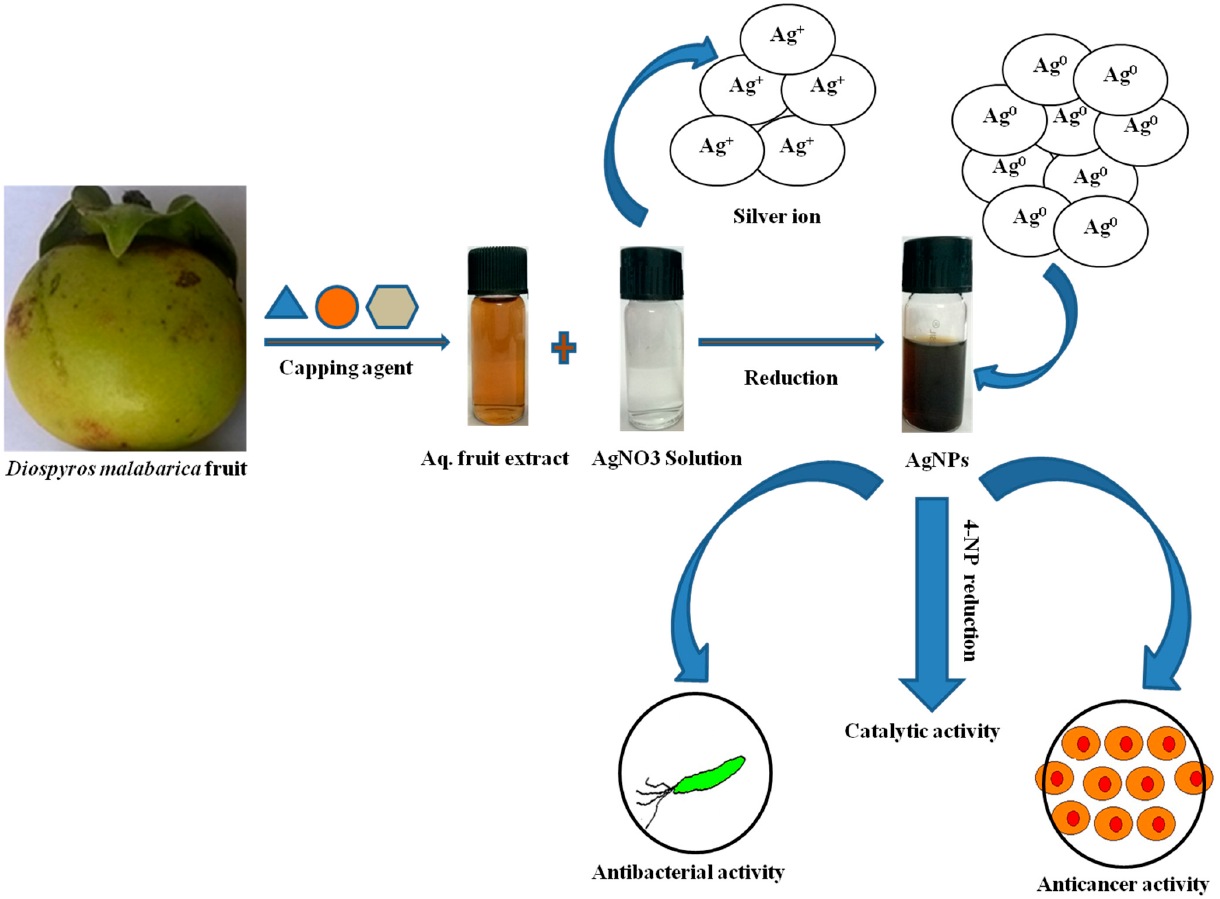
Figure 1. Schematic representation of the green synthesis of silver nanoparticles (AgNPs) and their applications.